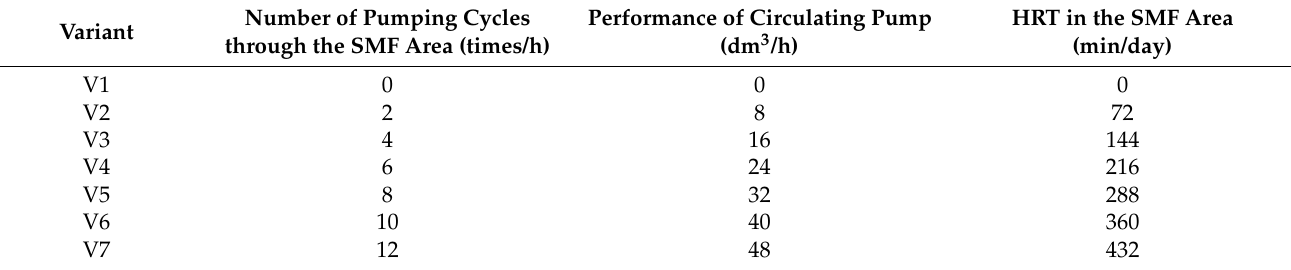
Table 1. Design of completed research works.